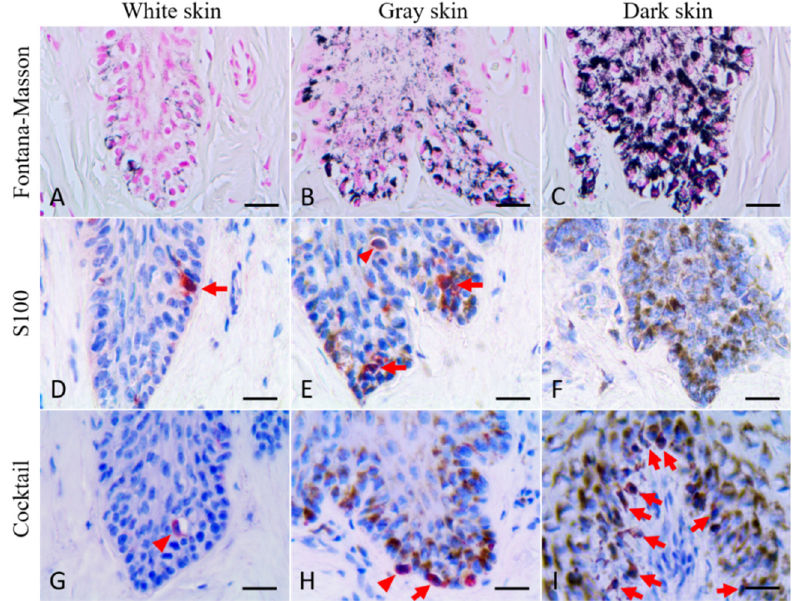
Figure 6. Fontana–Masson staining and immunohistochemical staining with anti-S100 antibody and cocktail antibody in normal white/gray/dark skin of Fraser’s dolphins. Scale bars = 20 μ m. ( A – C ): Fontana–Masson staining. ( D – F ): IHC staining with anti-S100 antibody. ( G – I ): IHC staining with cocktail antibody. Some immunoreactive cells had a round to oval nucleus with clear cytoplasm (arrowhead), while some immunoreactive cells exhibited fusiform or dendritic morphology with long cytoplasmic processes (arrow). Table 2. Cell counting of melanocytes. Sample No.